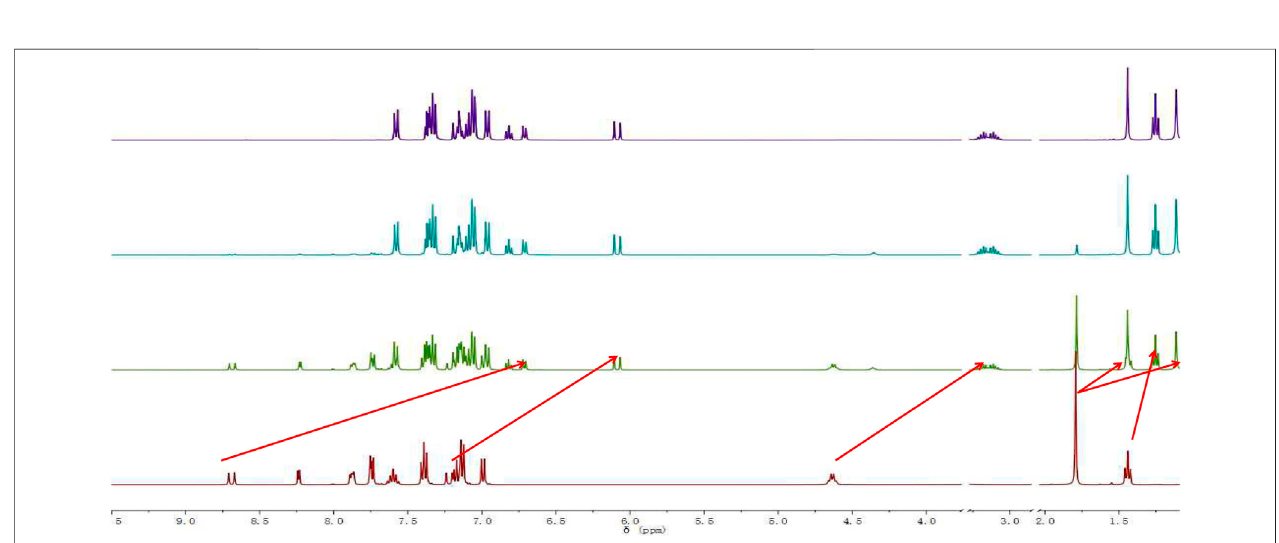
FIGURE 13 | NMR spectroscopic titration of the reaction product of probe W upon the addition of CN − .